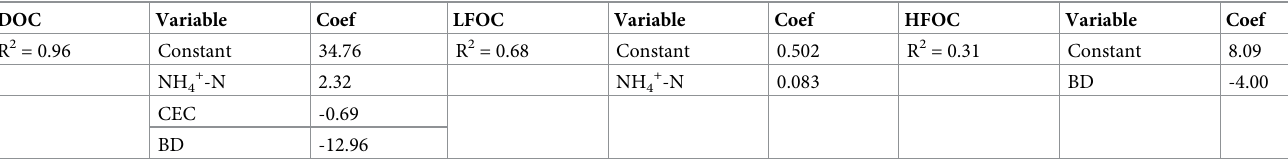
Table 3. Stepwise multiple linear regression for SOC in ZWP.